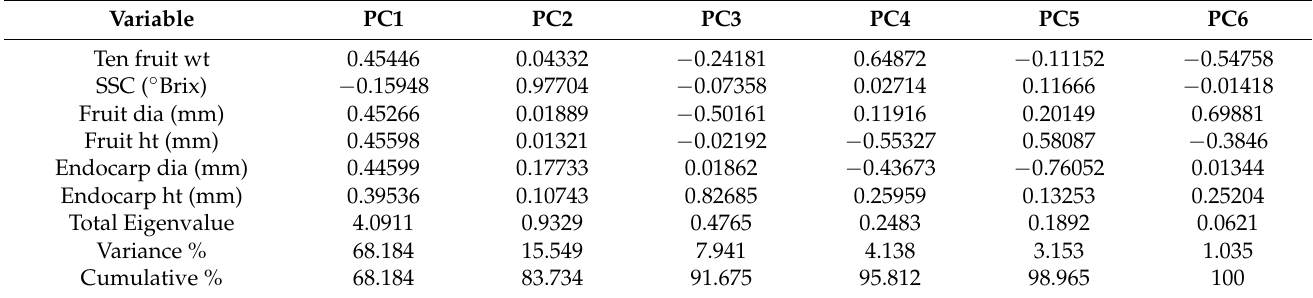
Table 7. Eigenvectors and proportion of the total variability for each principal component axes for fruit and endocarp characteristics of Prunus serotina subsp. capuli genotypes, collected in the Andes region of Ecuador in 2016 and